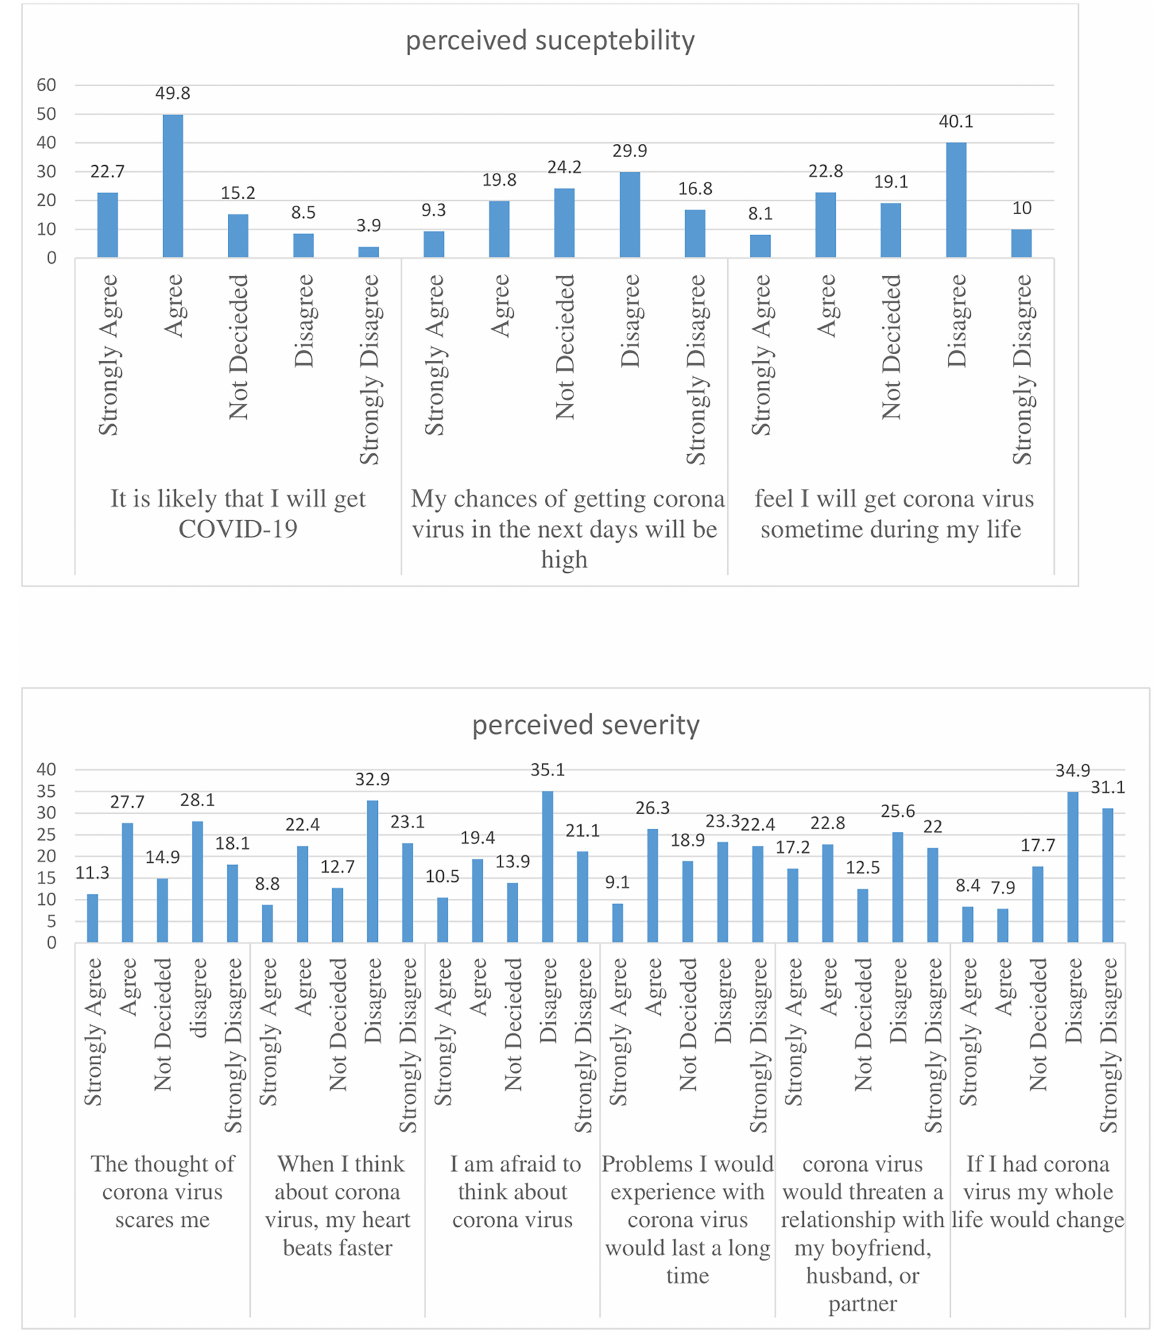
FIGURE1 Percentage of perceived susceptibility and severity attitude toward COVID-19 of the study